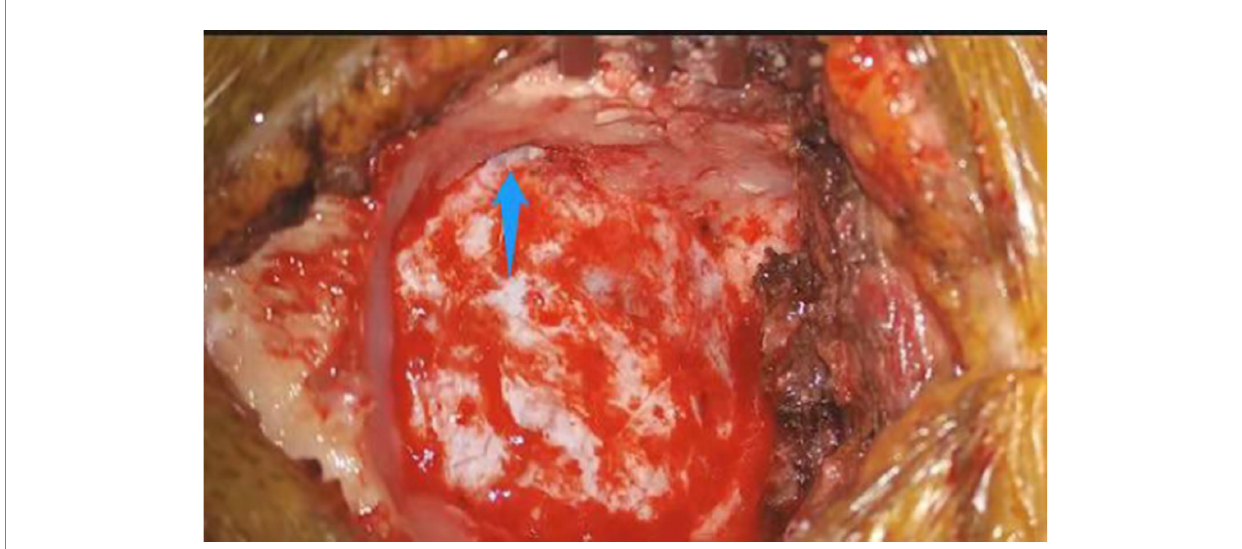
FIGURE 3 View of sigmoid sinus (pointed by arrow) during retrosigmoid approach on the right hemisphere.